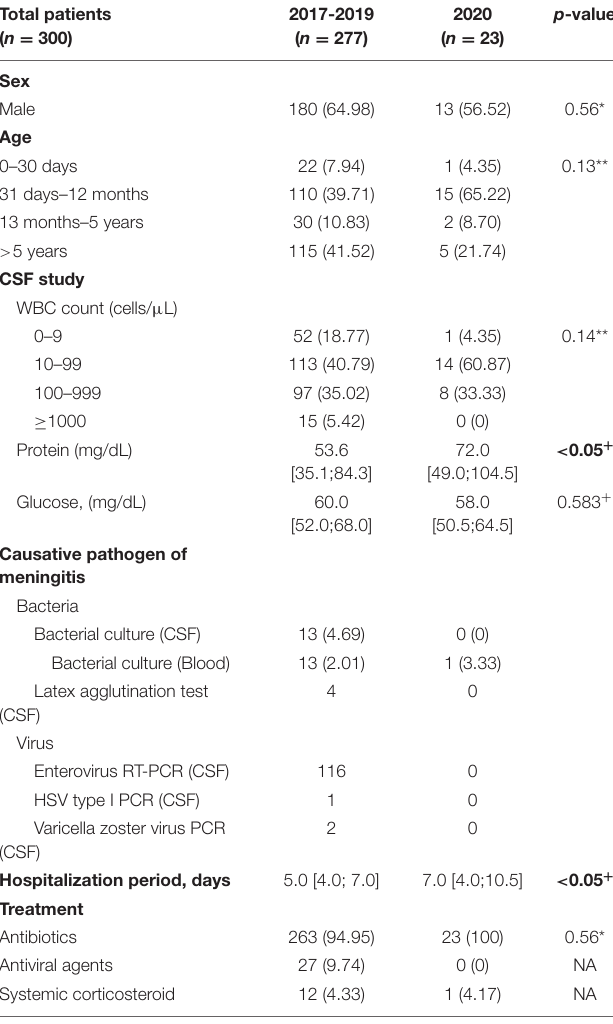
TABLE 2 | The characteristics of the patients that underwent CSF examination before and after the COVID-19